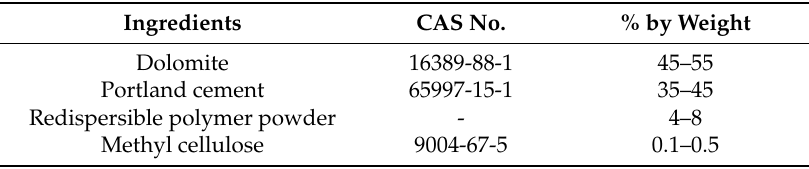
Table 2. Composition of ingredients of mortar